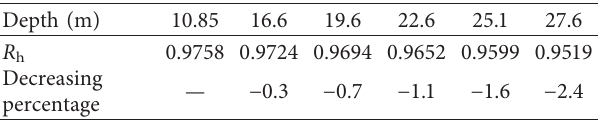
Figure 9: Effect of depth of drilling borehole on the skin friction of the existing foundation pile. Table 3: Effect of depth of drilling borehole on the end resistance of the existing foundation pile.